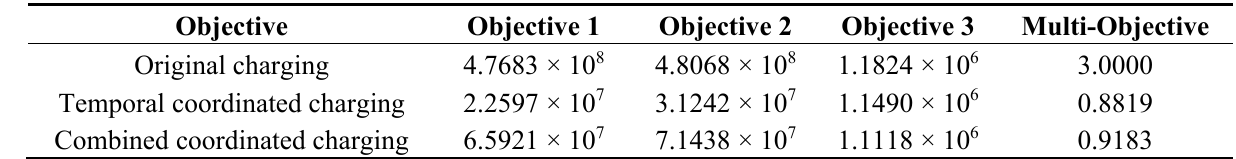
Table 4. Sub-objective value of temporal coordinated charging strategy.